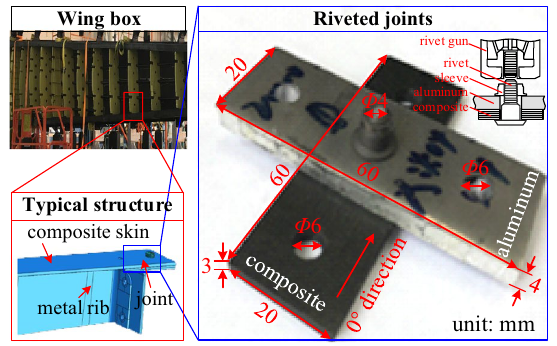
Figure 1 Composite/aluminum riveted joints specimen of airplane wing